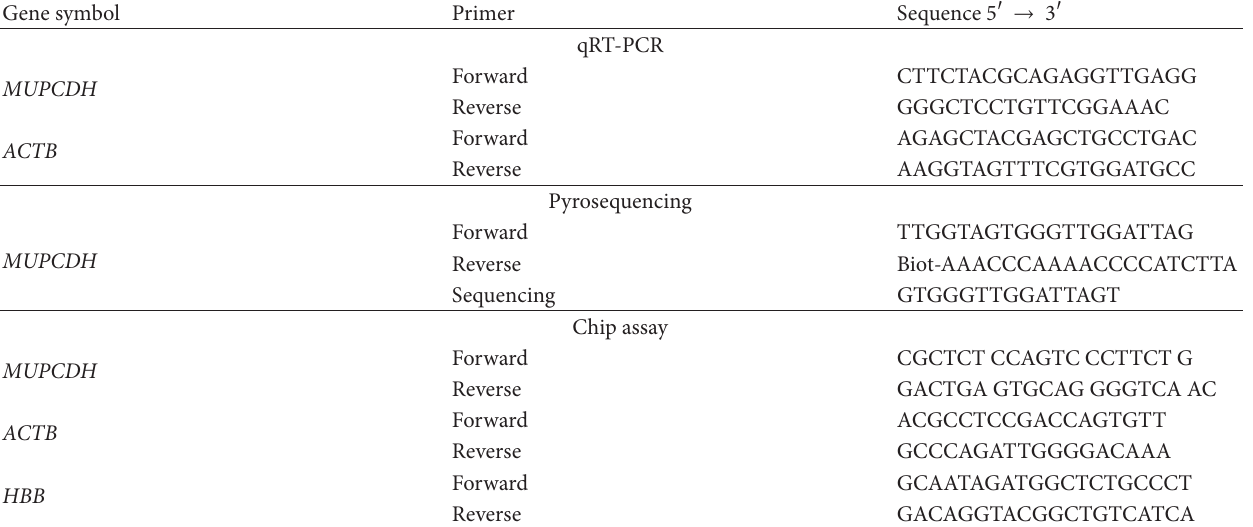
Table 2: PCR primers’